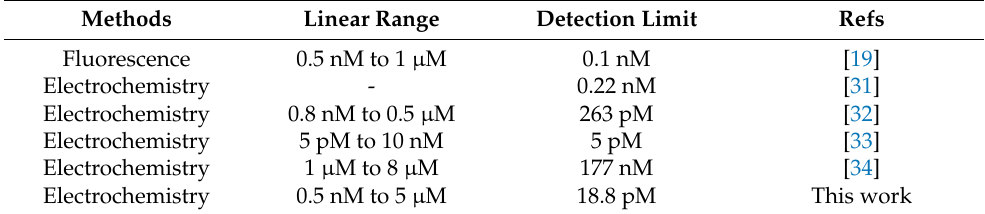
Figure 6. Typical SWV responses of the electrochemical DNA sensors to different concentrations of SA, from bottom to top (a to k): 0 nM, 0.5 nM, 1 nM, 5 nM, 10 nM, 50 nM, 100 nM, 200 nM, 500 nM, 1 µ M, and 5 µ M in a buffer solution (10 mM Tris–HCl, 100 mM NaCl, 20 mM MgCl 2 , pH 7.4). Logarithmic graph (inset) of ∆ I (nA) and target protein SA concentration (0.5 nM to 5 μ M). Error bars represent the standard deviation of the measurement (n = 3). Table 2. Comparison of the proposed assay with other established methods for DNA-binding protein